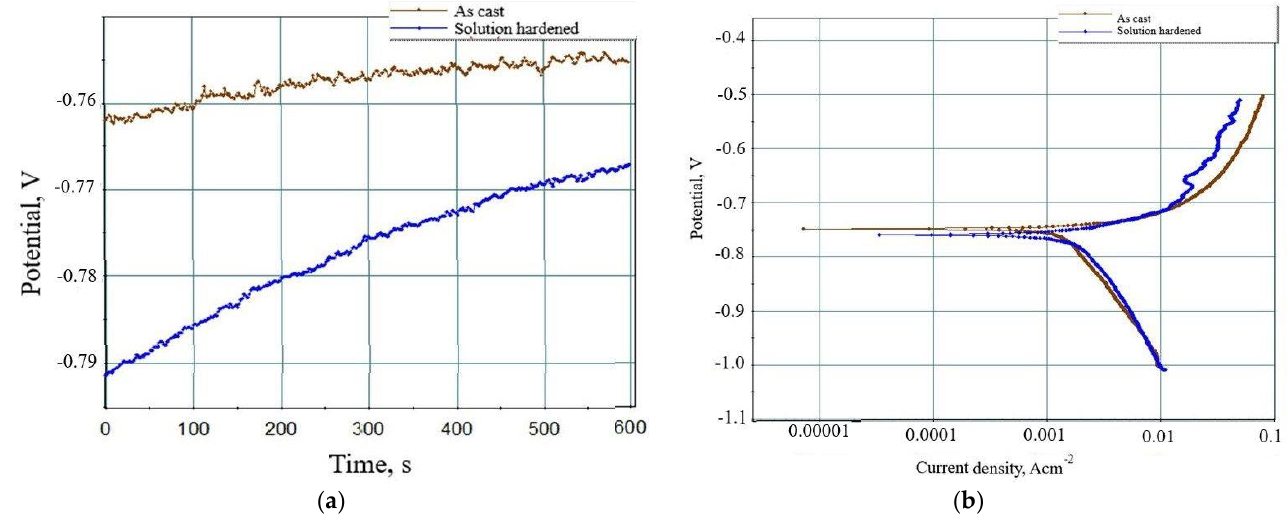
Table 5. The results of the EDS analysis of the solution-hardened sample performed on the details